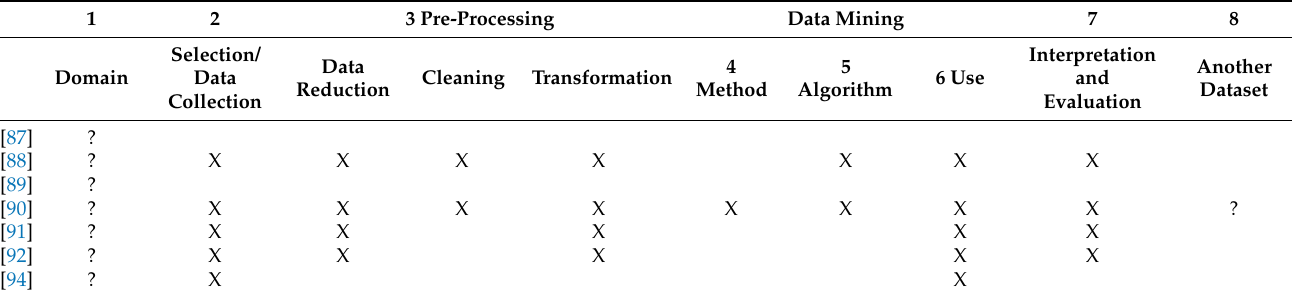
Table 1. Comparison between the KDD phases used in the